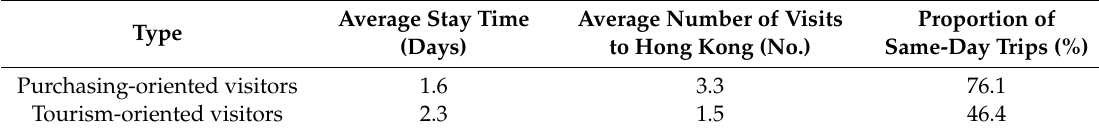
Figure 11. Kernel density of shopping-oriented visitor check-in records. Table 5. Comparison of the visit patterns of purchasing-oriented visitors and tourism-oriented